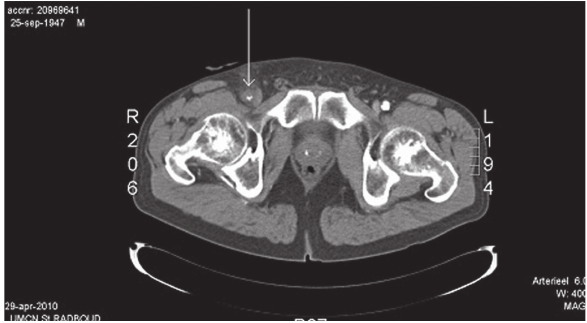
Fig. 1- CT angiography, occluded right commune femoral artery, Angio Seal